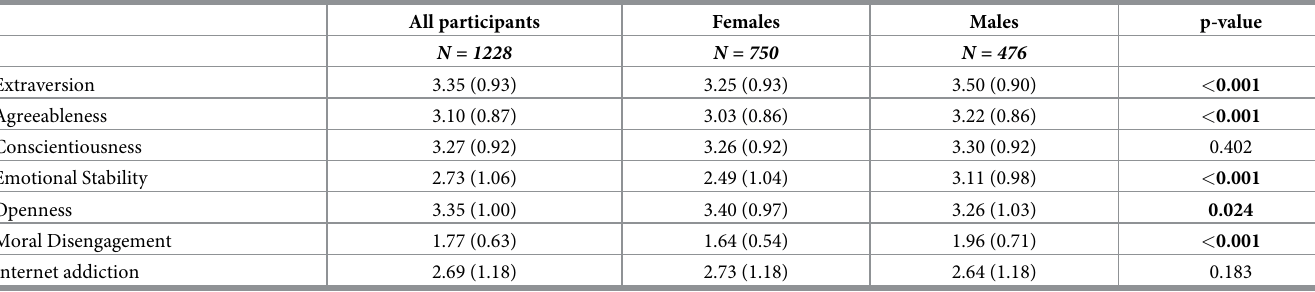
Table 2. Descriptive statistics about personality, moral disengagement and internet addiction. All